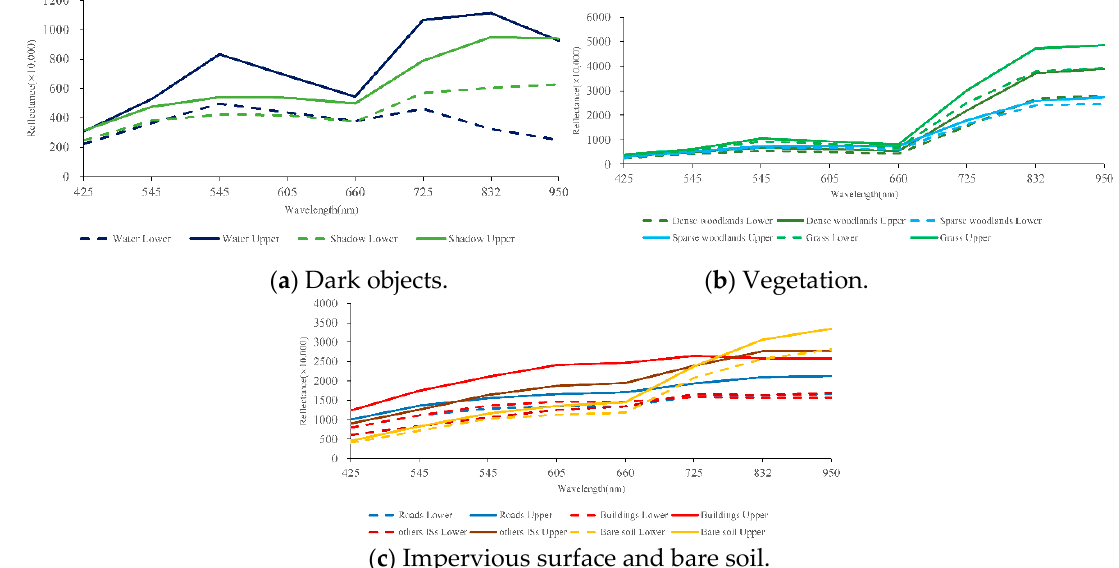
Figure 12. The true spectral curves of nine land covers (wavelength: nm). The x-axis is the wavelength, and the y-axis represents the reflectance for a scale factor of 10,000.